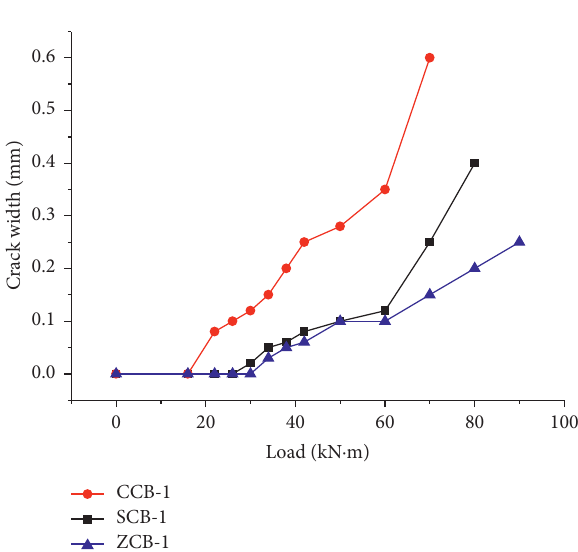
Figure 13: Development of crack